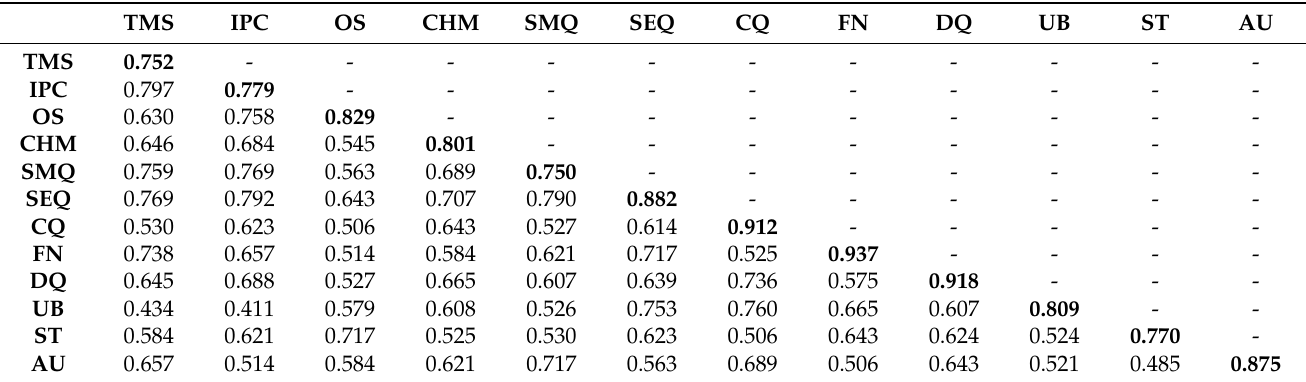
Table 4. AVE Analysis.